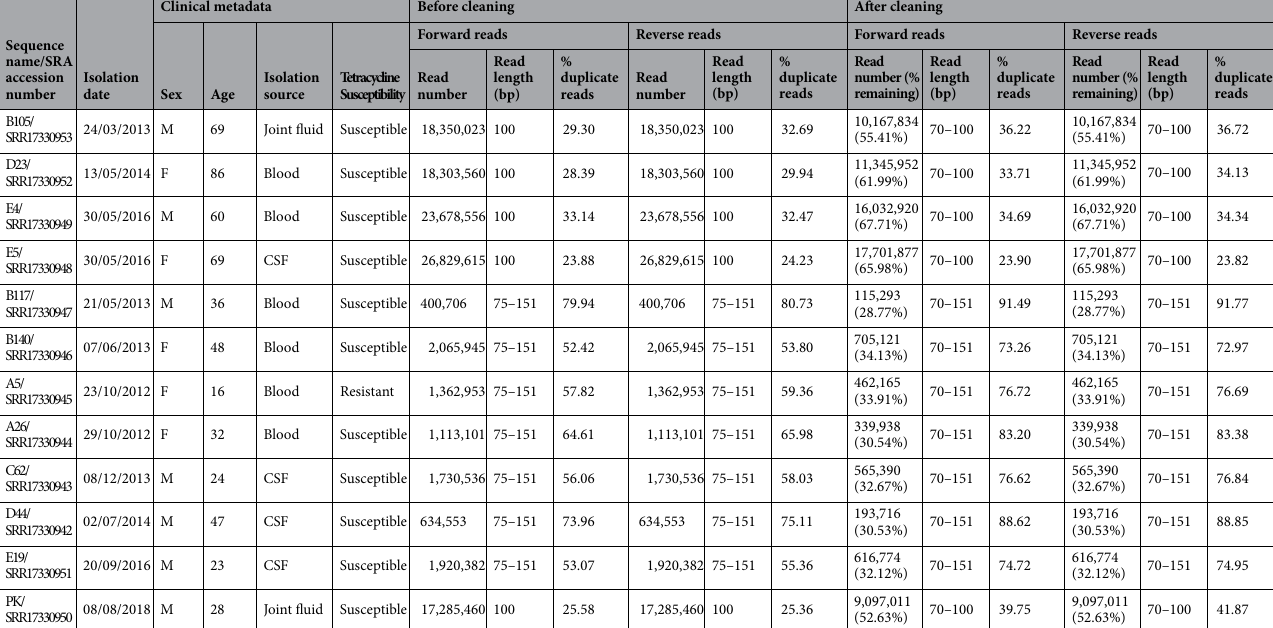
Table 1. Whole genome sequencing summary statistics. Low quality reads in the datasets were removed by using Trimmomatic 40 with the following parameters: PE = phred33; SLIDINGWINDOW = 4:30; MINLEN =